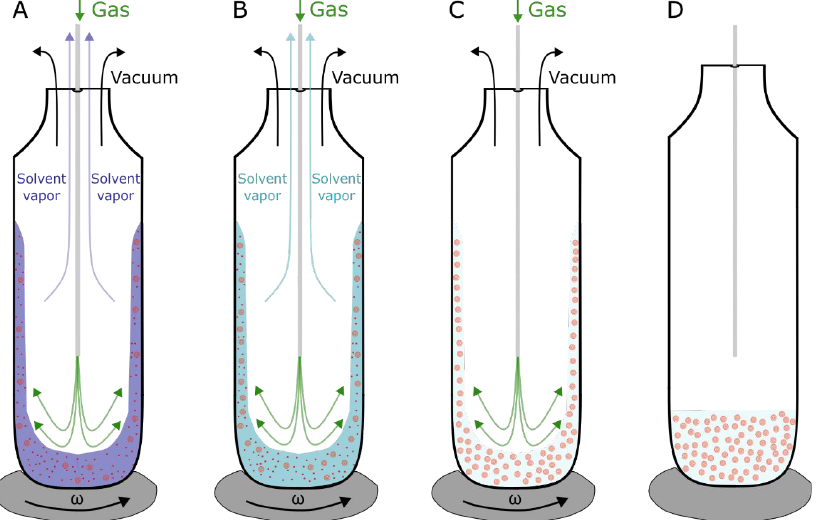
Figure 4. Schematic depiction of the RSE method. ( A ) Organic solvent (chloroform) (blue) containing lipids (red) is mixed with aqueous solution, and removal of organic solvent is achieved by vortexing the solution under vacuum. The process is made more efficient by adding a flow of inert gas (argon) (green) pushing the organic solvent vapors out. ( B ) MLVs start to form. The vacuum pressure is set below the organic solvent evaporation point but higher than the evaporation point of water. ( C ) Exchange is finished when all the organic solution is evaporated and only aqueous solution containing formed MLVs is left. ( D ) When MLVs are formed, vortex is turned off, and vacuum and gas flow pipes are closed. As reported in [40], the whole process takes less than a minute. SUVs and LUVs are used as intermediate steps in protocols for GUVs production [41] or the formation of supported lipid bilayers (SLBs) [42]. In order to form SUVs and LUVs, MLVs are usually produced first. The sonication of the MLV suspension produces SUVs with diameters in the range of 15 to 50 nm. During extrusion, the MLVs suspension is passed through a polycarbonate filter and a membrane with pores of different sizes. The extruder is positioned on a hot plate, with the temperature set above the highest transition temperature of all the lipids in the mixture. To achieve a homogeneous unilamellar vesi- cles population, the MLV suspension has to be passed through the pores around 15 times. The final vesicle diameters are determined by the size of the membrane pores. It should be noted that formed vesicles usually have a somewhat larger average diameter than the pores, if the pore size is smaller than 200 nm [43]. This is due to the elasticity of the vesicle membranes, allowing them to squeeze through pores narrower than their nominal diam- eter. The size distribution of produced unilamellar vesicles can be verified using dynamic light scattering. Although less common, the freeze – thaw and the hand-shaking methods can also be used for SUV and LUV formation [37]. 2.1.2. GUVs GUVs are widely used for the investigation of membrane properties due to their size being similar to the sizes of eukaryotic cells. Most often, they are analyzed using optical microscopy techniques. Different approaches have been attempted for GUV production [37,44 – 47]. One of the first attempts was reported by Reeves and Dowben in 1969 [29]. The lipid mixture was deposited onto the surface and dried to form a lipid film. The lipid film is then rehydrated, and the solution is stirred to form GUVs. Due to osmotic pressure, the aqueous solution is driven between the lipid bilayer stacks. It is energetically unfavorable for the hydrophobic chains of lipids to be exposed to an aqueous solution, so lipid bilayers spontaneously close into spherical vesicles. Although simple and straightforward, the method produces a low GUVs yield, with lots of defects and a high proportion of MLVs